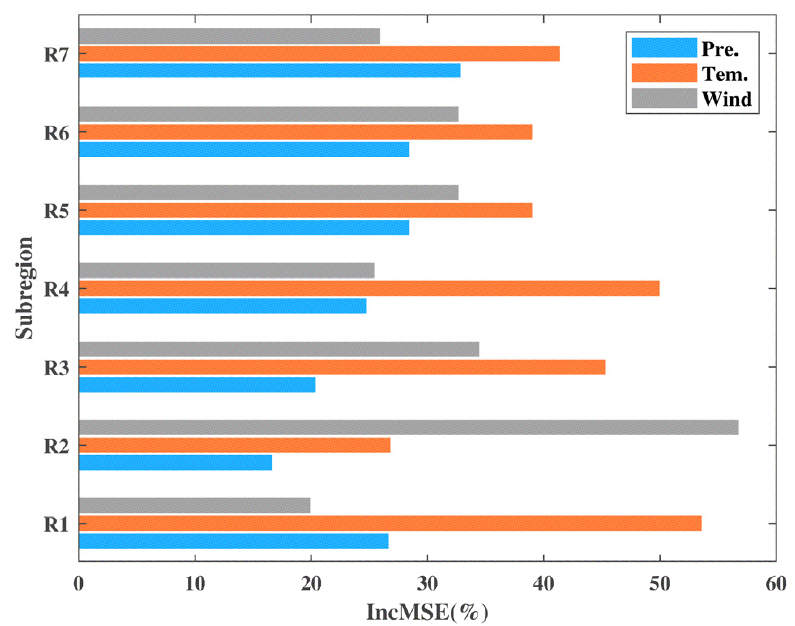
Figure 16. Contributions of the three climatic factors to annual BA in R1 − R7. IncMSE represents the increase in mean of squared error of random forest model in testing dataset when one variable is removed.